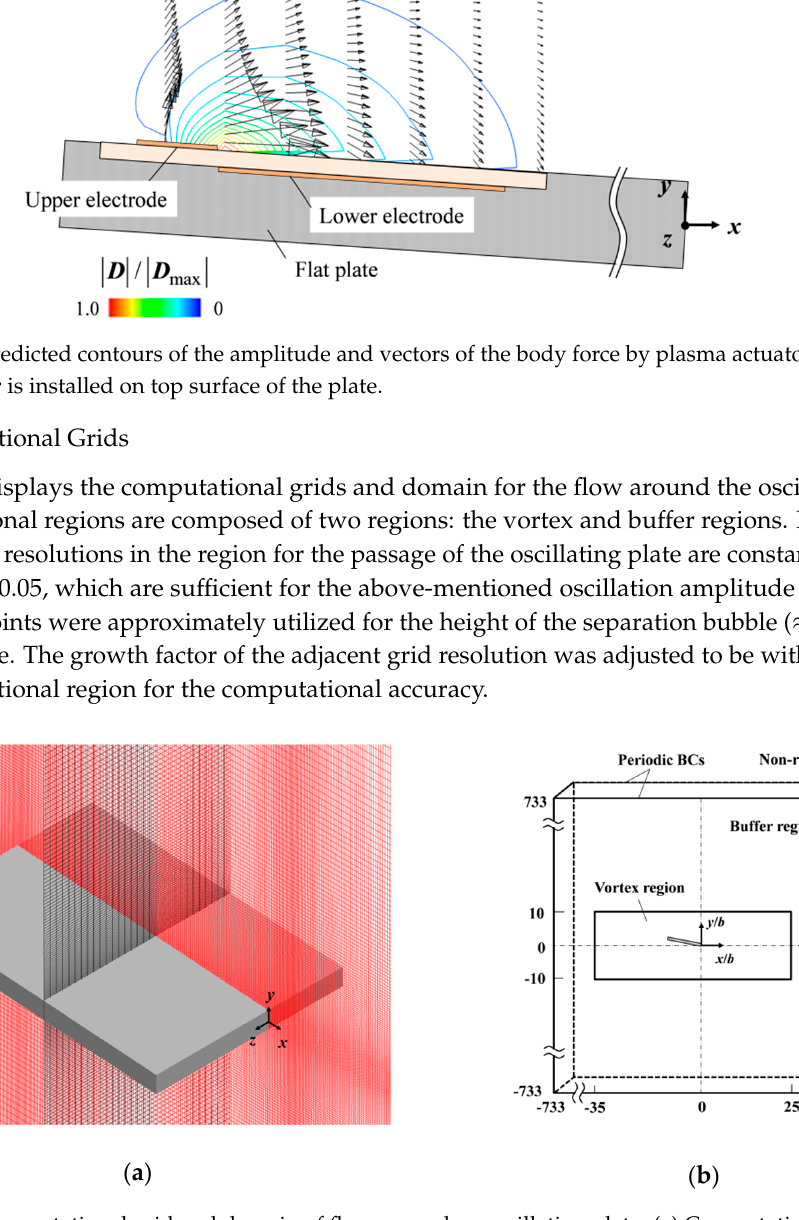
Figure 8. Computational grid and domain of flow around an oscillating plate. ( a ) Computational grid; ( b ) Computational domain and boundary conditions.